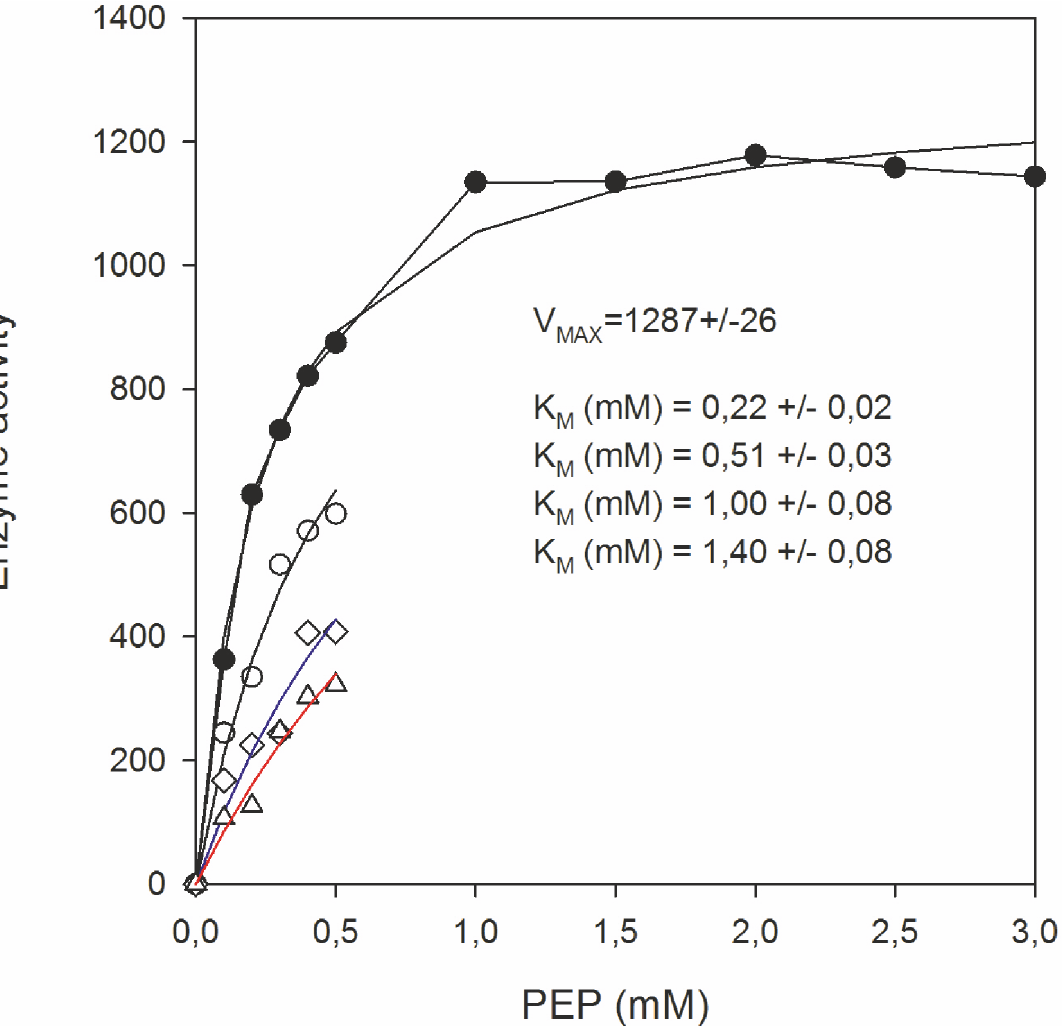
Fig 6. Competitive inhibition of pyruvate kinase activity by ethyl pyruvate. Enzyme activity was measured by following the production of ATP from the substrates phosphoenolpyruvate (PEP) and ADP as described in Materials and Methods. Enzyme activity expressed as nmole ATP/ μ l/s (ordinate) was recorded in dependence of increasing substrate concentrations (PEP) in the absence and presence of ethyl pyruvate. Controls were ( ● ) without ethyl pyruvate (K m = 0.22 ± 0.02 mM); ( (cid:4) ) 5 mM ethyl pyruvate (K m = 0.51 ± 0.03mM); ( ^ ) 10 mM ethyl pyruvate (K m = 1 ± 0.08mM) and ( Δ ) 15 mM ethyl pyruvate (K m = 1.4 ± 0.08mM). The pure enzyme from rabbit muscle (200 U/mg) was used for the experimental setup to avoid contamination bias in our cell extract. The K m and K i values were calculated by SIGMAPLOT (Systat Softwarwe